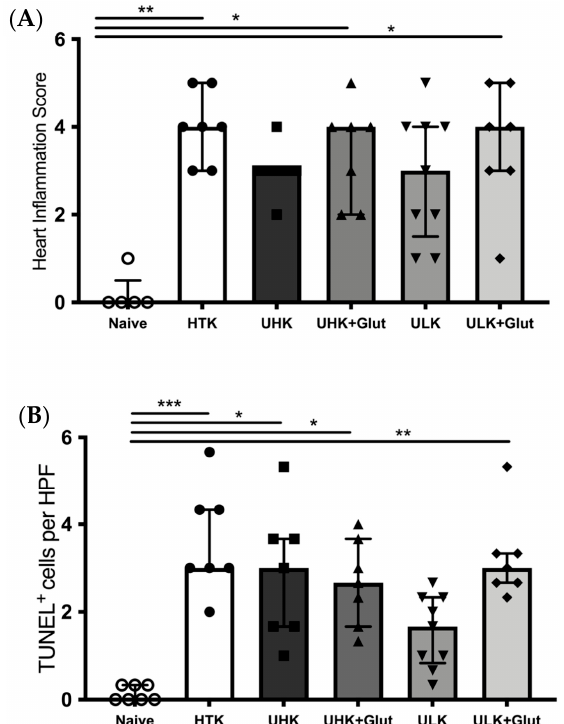
Figure 3. ( A ) Heart inflammation score and ( B ) assessment of apoptosis using TUNEL staining. ( A ) H&E-stained tissue sections were evaluated for the amount of cellular infiltrate using a